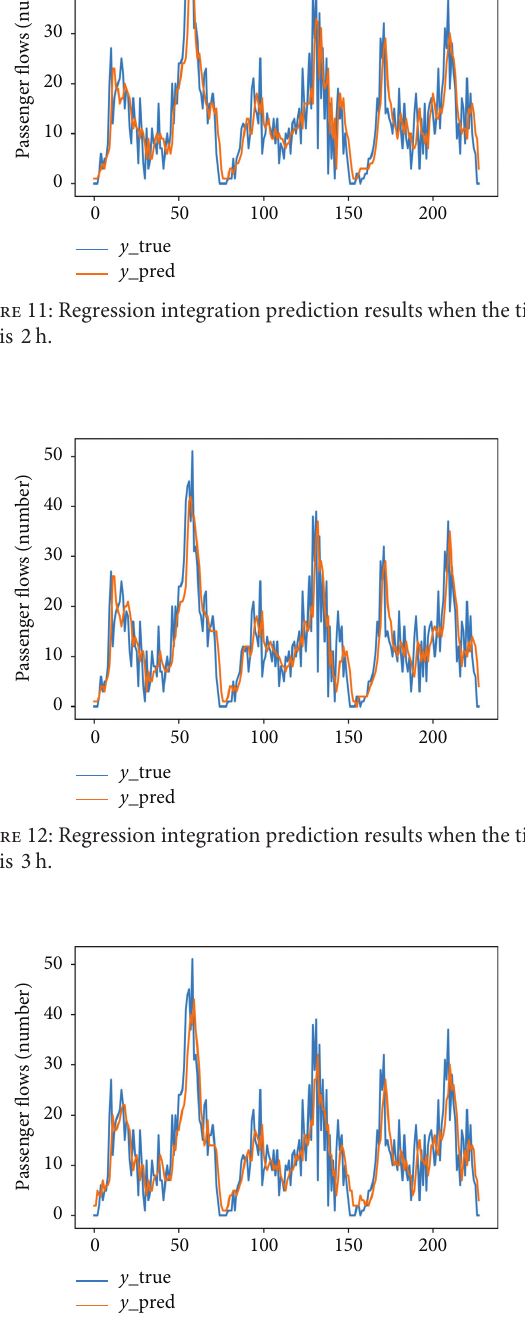
Figure 13: Regression integration prediction results when the time step is 6h.